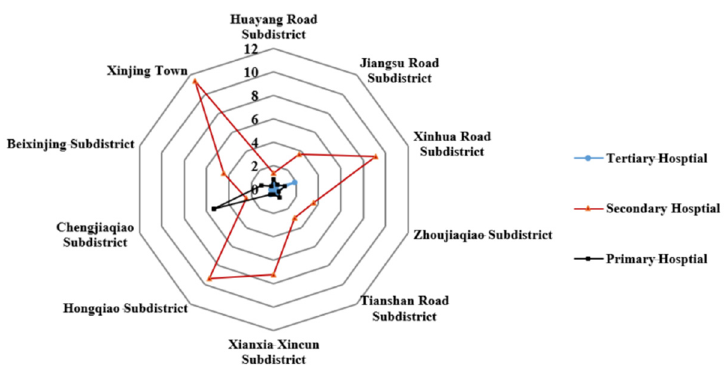
Figure 10. Spatial accessibility of different-grade hospitals in each subdistrict.